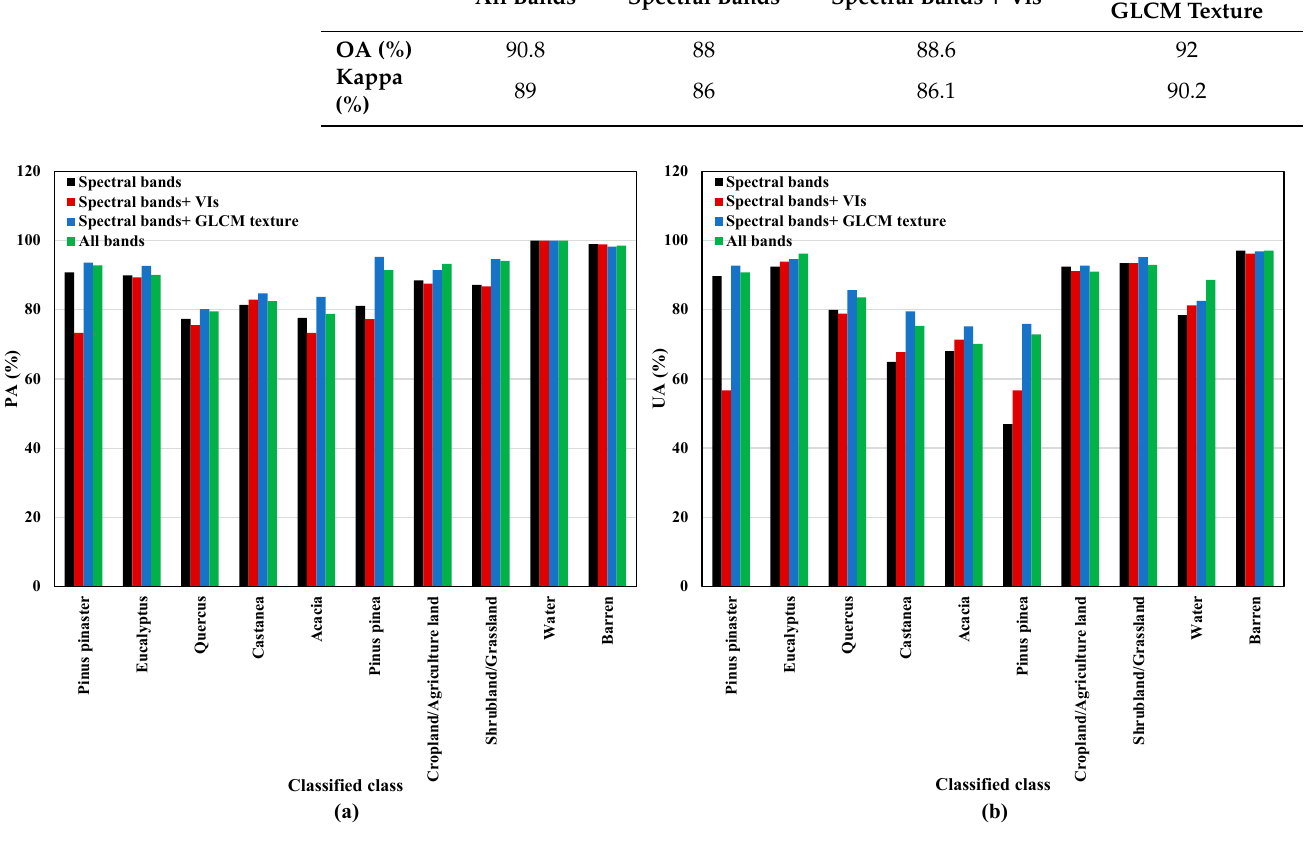
Figure 6. Class accuracy for different combinations of independent variables: ( a ) producer accuracy and ( b ) user